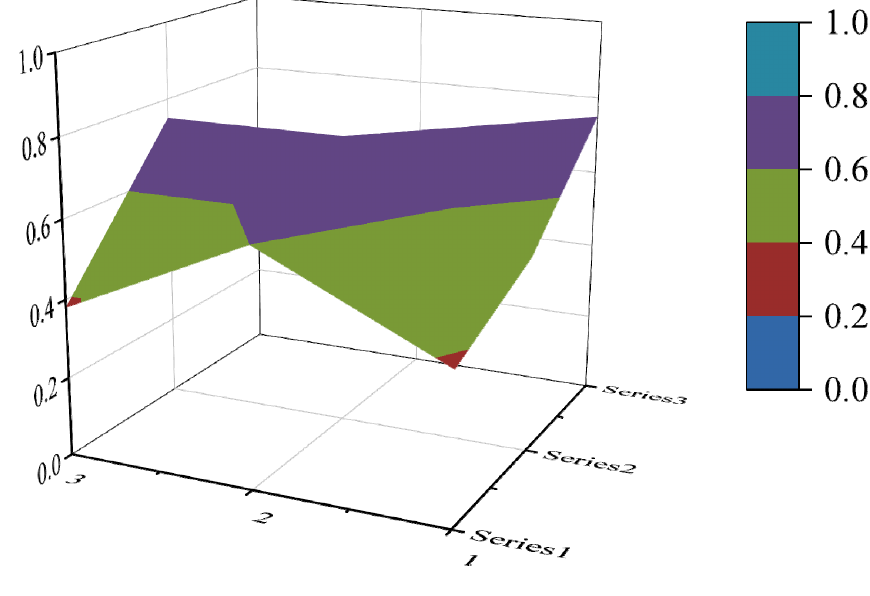
Figure 6. The PMC surface of P5.